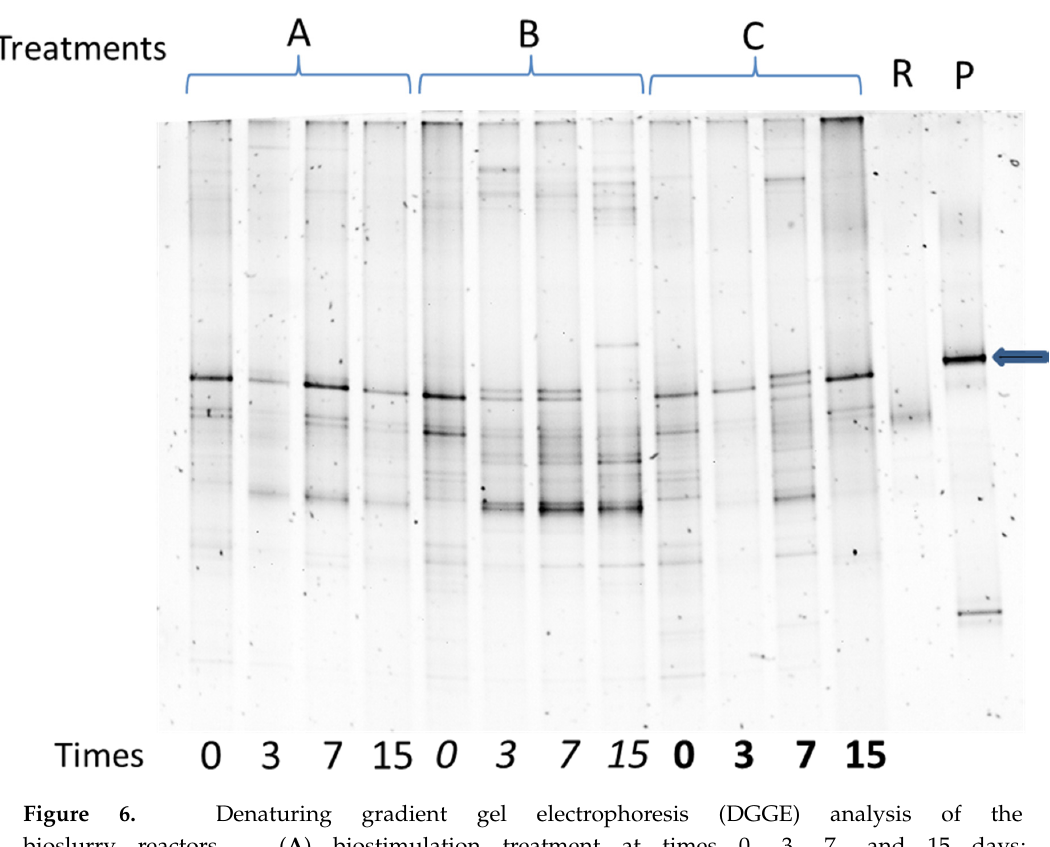
Figure 6. Denaturing gradient gel electrophoresis (DGGE) analysis of the bioslurry reactors. ( A ) biostimulation treatment at times 0, 3, 7, and 15 days; ( B ) Rhodococcus biostimulation-bioaugmentation experiment; ( C ) the same from Pseudomonas biostimulation–bioaugmentation experiment; R and P bands correspond to R. erythropolis and P. stutzeri alone, respectively (arrow).